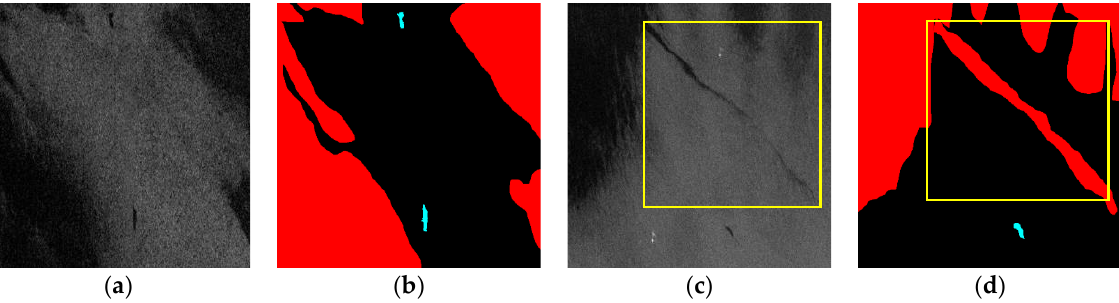
Figure 2. ( a , c ) are samples of SAR images with large oil-spill-like areas and small oil area inclusion, ( b , d ) are labels. The long stripe area (in the yellow square) may cause some problems in the model due to the relatively asymmetric mark.